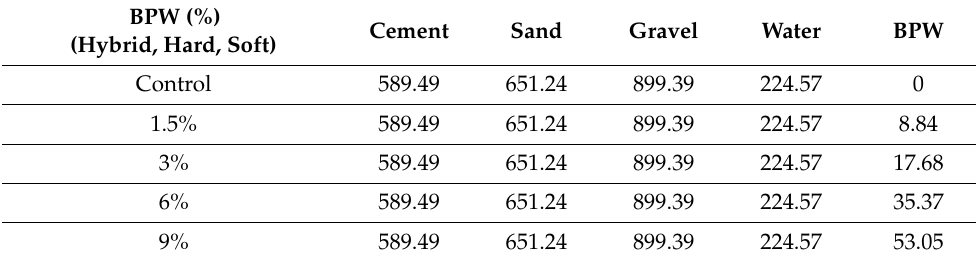
Table 2. Concrete mix design (kg/m 3